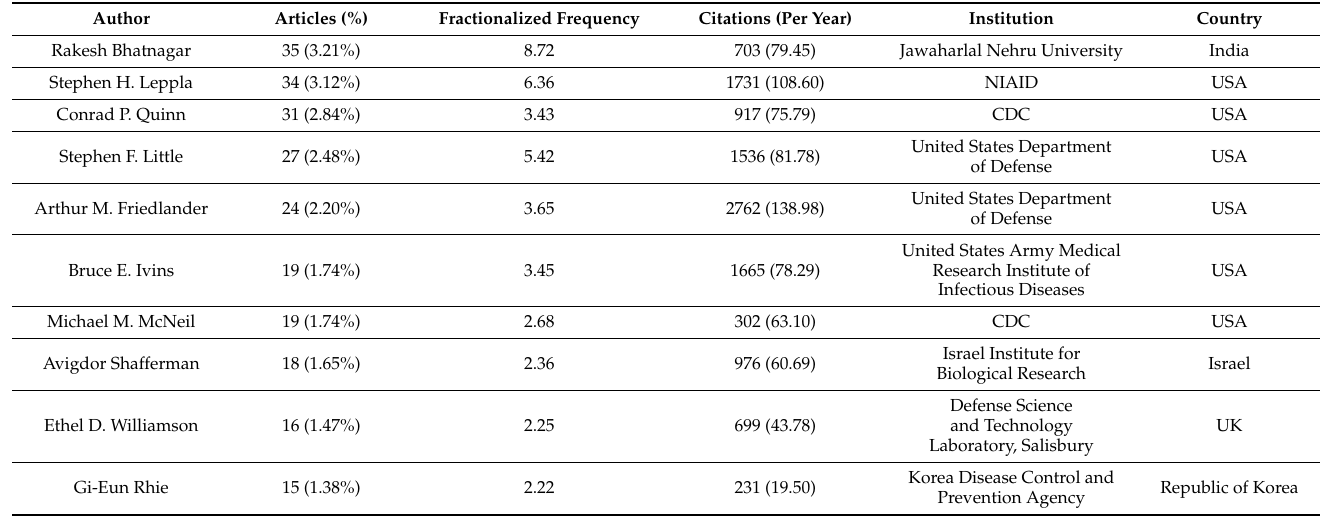
Table 3. Details of authors who published at least 15 anthrax vaccine-related articles.